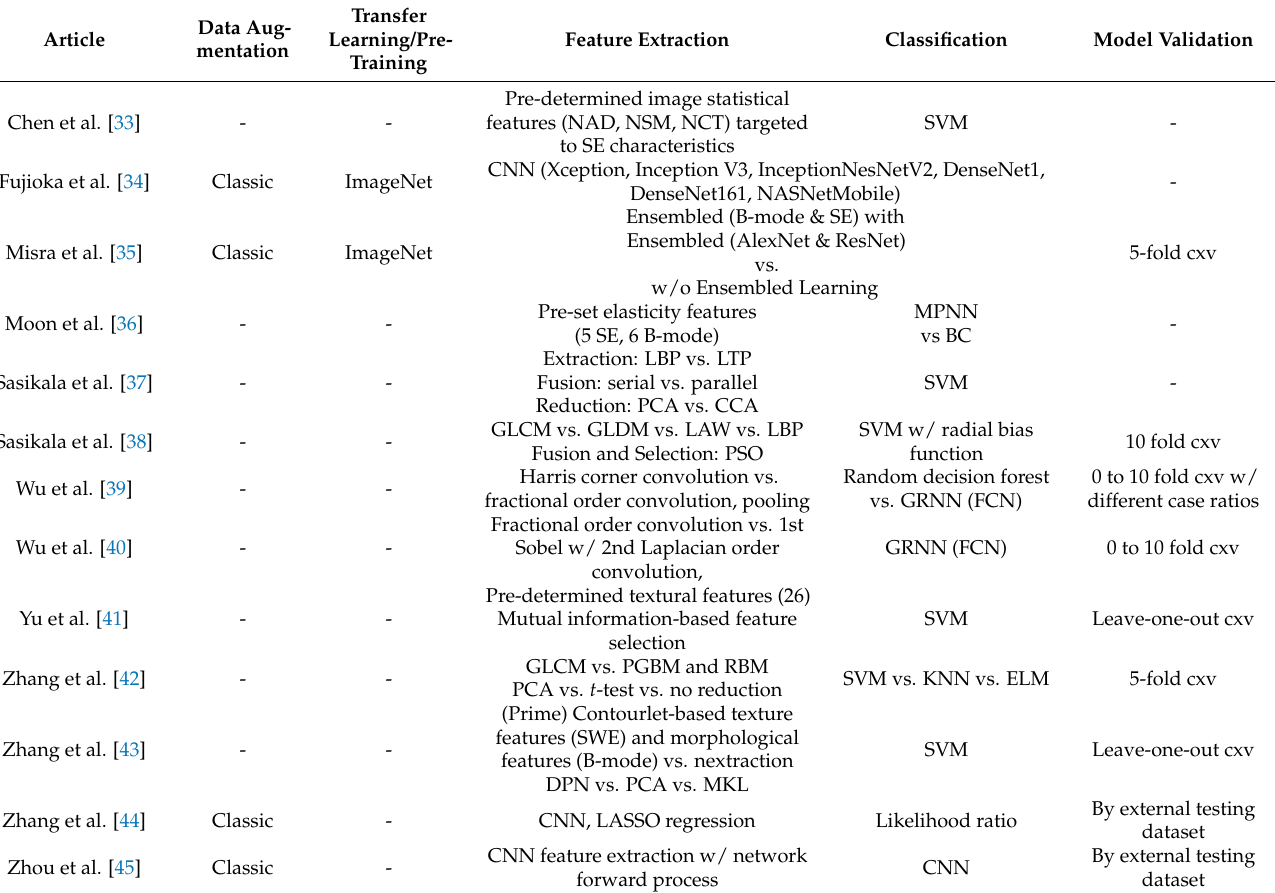
Table 3. Configuration of machine learning and classification